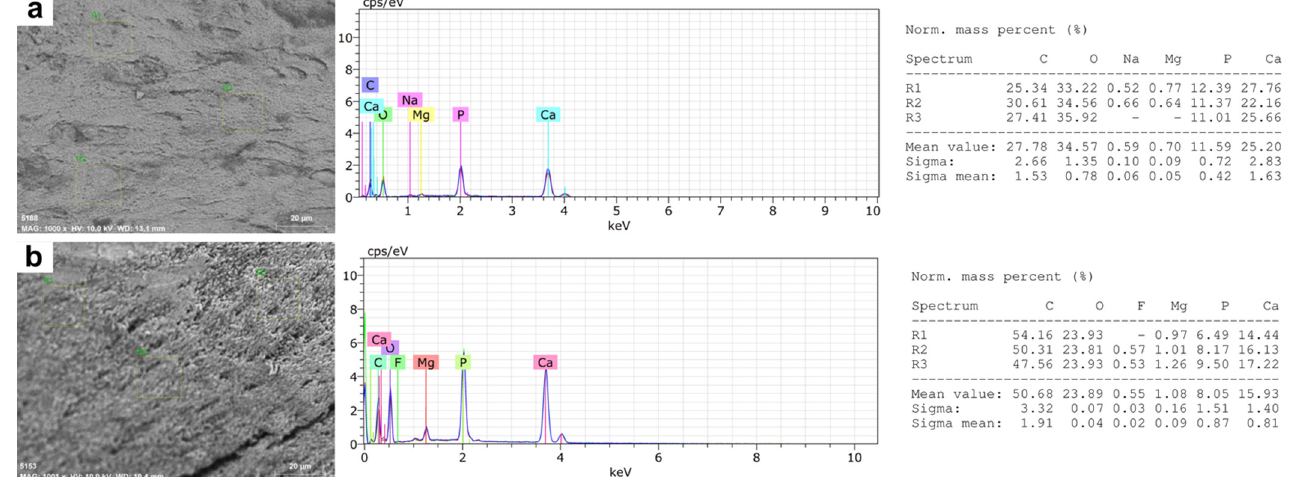
Figure 5. Microstructure of rainbow trout ( Oncorhynchus mykiss ) jawbone. Farmed fish at 1000×, 2000× and 5000× magnification ( a – c ). Wild fish at 1000×, 2000× and 5000× magnification ( d – f ). Backscatter detector (BSD) image. Scanning Electron Microscope SU3500, Hitachi, Tokyo, Japan.